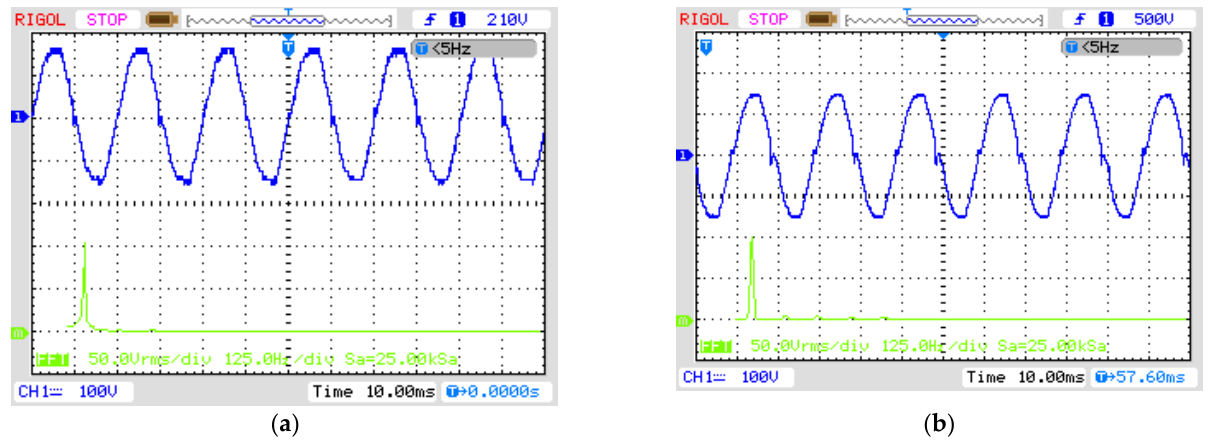
Figure 17. Standard frequency (50 Hz) outputs during: ( a ) non-inverting state; ( b ) inverting state. The inverting and non-inverting characteristics of the output voltage are employed to vary the frequency at the output in discrete steps. Figures 18 and 19 represent the low and high-frequency outputs respectively. The investigation of Figure 18a–c concludes that during the positive half period of the output, all positive half cycles and negative half cycles of input at the output are non-inverted and inverted respectively. The situation will be reversed during the negative half period of the output voltage. In this interval, all the positive half cycles of the input at the output are inverted while all negative half cycles of input at output remain non-inverted. Figure 18a–c depicts the practically obtained waveform for output frequency one-fourth, one-third, and one-half of the input frequency respectively. The one-half cycle of the output voltage of Figure 18a at 80 ms is distorted due to the flow of low-frequency components of the current in the ac power supply as it is designed at standard supply